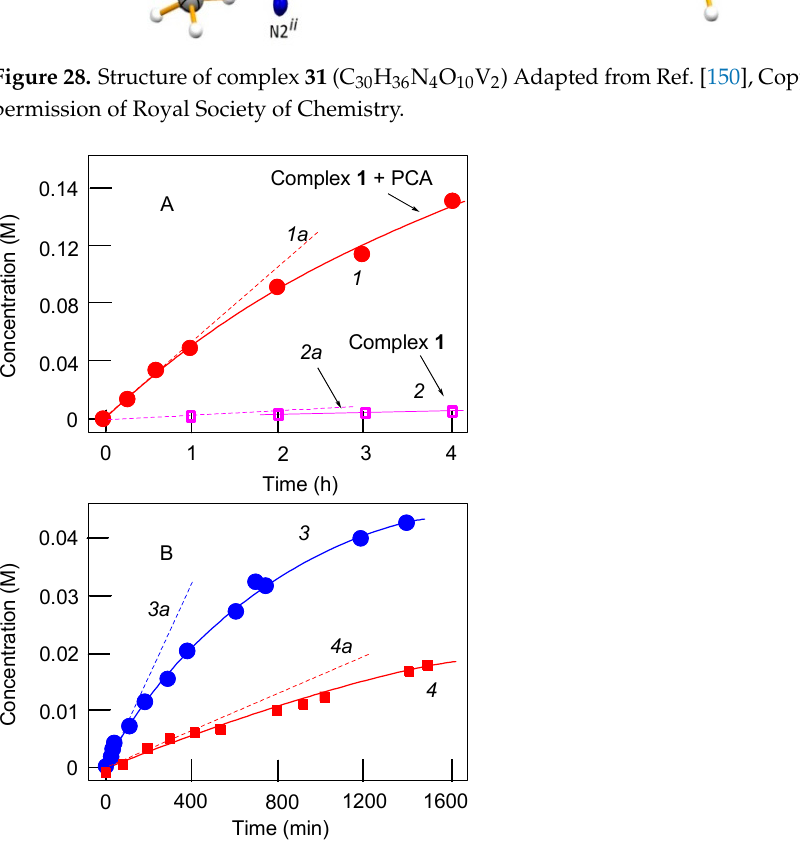
Figure 29. Oxidation of cyclohexane with the H 2 O 2 /31/PCA/CH 3 CN–H 2 O (curve 1 ). Curve of accumulation of oxygenates (predominantly cyclohexyl hydroperoxide) in the absence of PCA (curve 2 ) are shown. For Graph A : [catalyst 31 ] 0 = 2.0 × 10 –5 M; [PCA] 0 = 0.005 M; [H 2 O 2 ] 0 = 2.2 M (50% aqueous), [H 2 O] total = 4.2 M; [cyclohexane] 0 = 0.46 M; MeCN; 50 °C. For Graph B : [catalyst 31 ] 0 = 1.0 × 10 –6 M (curve 3 ) or 5.0 × 10 –7 M (curve 4 ); [PCA] 0 = 6 × 10 –4 M; [H 2 O 2 ] 0 = 0.4 M (50% aqueous), [cyclohexane] 0 = 0.4 M; MeCN; 50 °C. Maximum initial rates W 0 were determined from the slopes of tangents (two ex- amples are depicted with straight dotted lines 1a , 2a , 3a and 4a ) to the kinetic curves in the intervals where the rate attains maximum (in these cases in the beginning of the oxidation reaction). Adapted from Ref. [150] Copyright (2013) with permission of Royal Society of Chemistry.